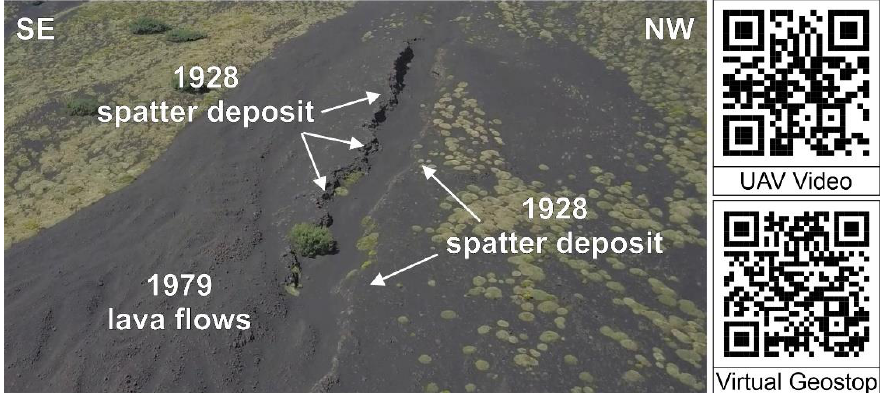
Figure 5. The image on the left shows geostop 3 through a SW-looking UAV-captured picture. The QR codes on the right enable opening the corresponding UAV-captured video and the related VG. By using a mobile phone or a tablet, open up the QR code reader. Hold your device over a QR code, so that it is clearly visible on your screen. Press the notification and wait a few seconds.